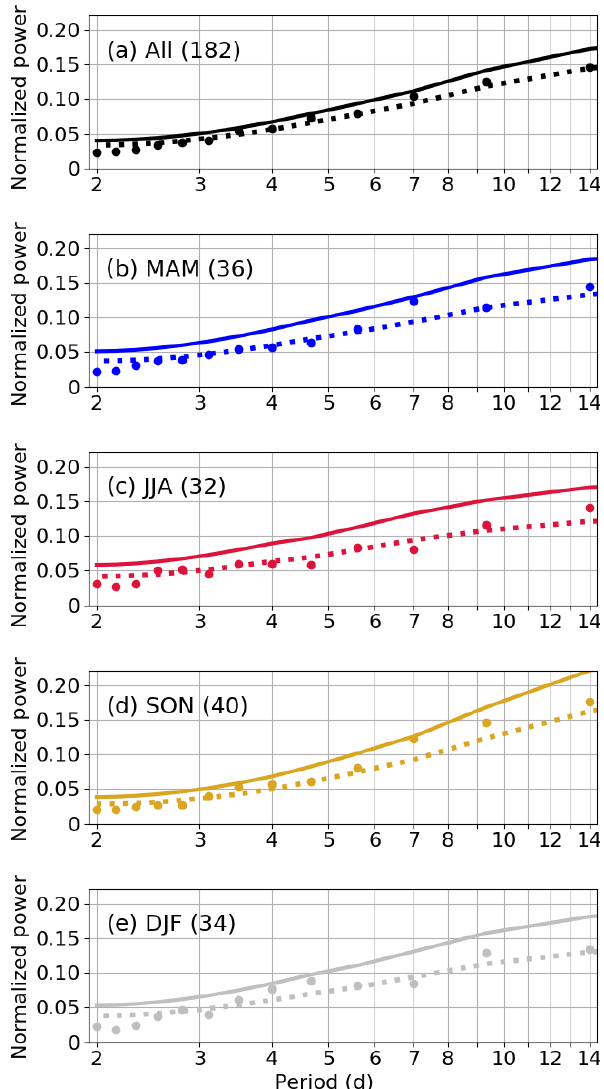
Figure 14. Normalized power spectra for 2–14d cycles for the to- tal aerosol number concentrations from the CPC for the entire pe- riod (a) and by season (b–e) . The dots represent power associated with the data. The dashed lines represent an estimate of the red noise power spectrum for each dataset, and the solid lines represent the 99% significance testing level, as described in the text. The values in the parentheses are the number of 28d data chunks used in this